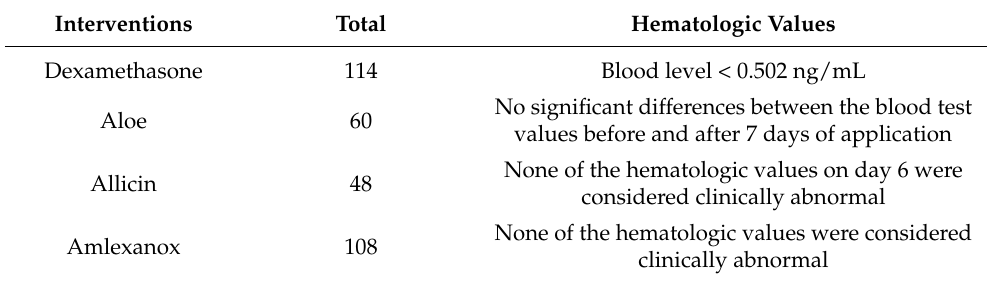
Table 3. Hematologic